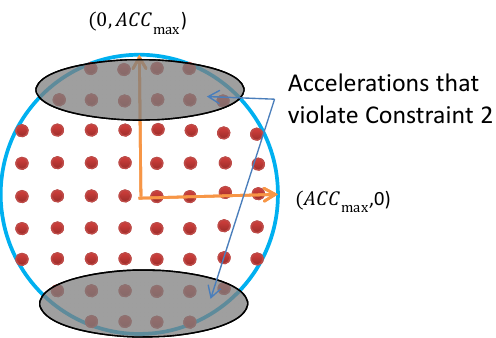
Figure 3. The red points show the discretized possible acceleration vectors at time t that satisfy the motion constraints.